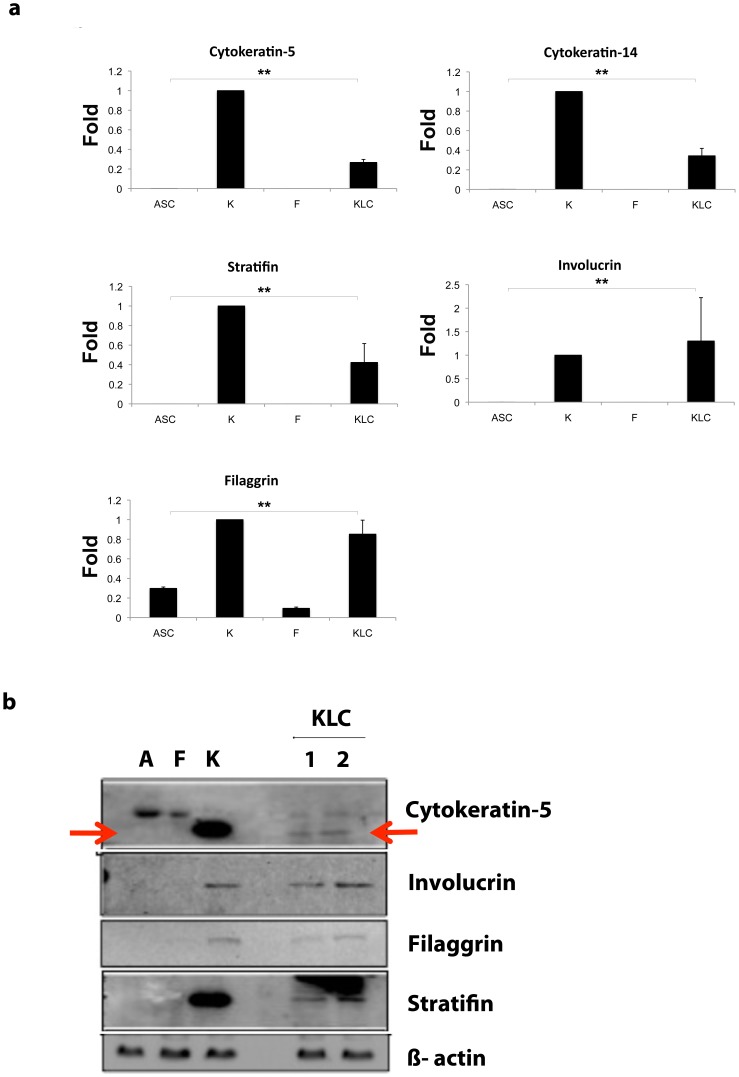
KLC express keratinocyte markers.We evaluated ASC transdifferentiation into KLC by the expression of several keratinocyte markers such as, keratins, involucrin, stratifin and filaggrin. (a) mRNA expression of cytokeratin-5, cytokeratin-14, stratifin, involucrin and filaggrin in ASC, keratinocytes (K), fibroblasts (F), and KLC. Keratinocyte and fibroblasts were used as positive and negative control, respectively. The panel shows the absence with the exception of filaggrin of all other keratinocytes markers in ASC and fibroblasts, and the positive expression of these markers in KLC after ASC-transdifferentation, (Cytokeratin-5, 0.26±0.03 vs. 0.0008±0.0001; cytokeratin-14, 0.34±0.07 vs 0.001±0.000089; stratifin, 0.42±0.19 vs 0.000055±0.0000056 and involucrin, 1.3±0.9 vs 0.0008±0.0005; respectively). In the case of filaggrin, KLC showed almost a 3 fold up-regulation when compared to that of ASC (0.85±0.14 vs 0.29±0.01; respectively) **p<0.01; n = 3 independent experiments. Keratinocytes were normalized to 1 since these cells possess these markers. Statistical analysis was obtained comparing KLC to ASC. (b) Western blot analysis confirmed the mRNA findings. KLC showed the presence of cytokeratin-5, involucrin, filaggrin and stratifin proteins comparable to those from keratinocyte lysates, however no bands were detected in ASC or fibroblast lysates. (Arrows indicate Cytokeratin-5 band, according to its molecular weight. Upper bands may correspond to unspecific binding at a higher molecular weight not corresponding with cytokeratin-5 molecular weight) (Image representative n = 3 independent experiments).